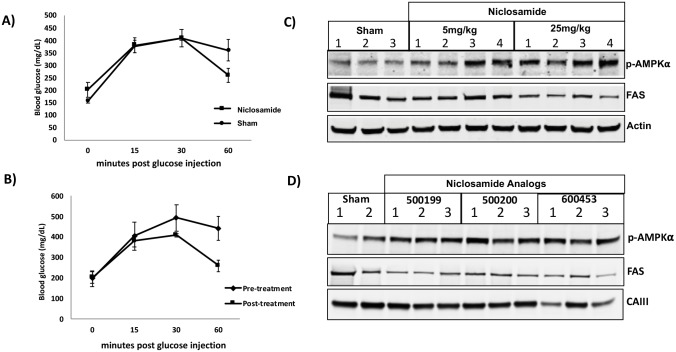
Niclosamide improves glucose tolerance and alters biomarkers of NAFLD and hepatic steatosis.Glucose tolerance test in DIO mice. 2g/kg of glucose was injected IP and at 15, 30 and 60 min, blood glucose levels were measured. (A) Averaged glucose tolerance for 7-day sham cohort and 5 mg/Kg Niclosamide treatment group (n = 3 each, P = 0.05). (B) Comparison of pre and post-7 day treatment with 5 mg/kg Niclosamide (n = 3, P = 0.034). C) Western blot analyses of phosphorylated AMPKα T172, Fatty acid synthase (FAS) and carbonic anhydrase III (CAIII) protein expression in liver tissue samples from male C57BL/6J mice fed HFD treated with 10mg/kg Niclosamide or D) 500200, 500199 or 600453 for 12 days relative to Sham HFD alone (control).